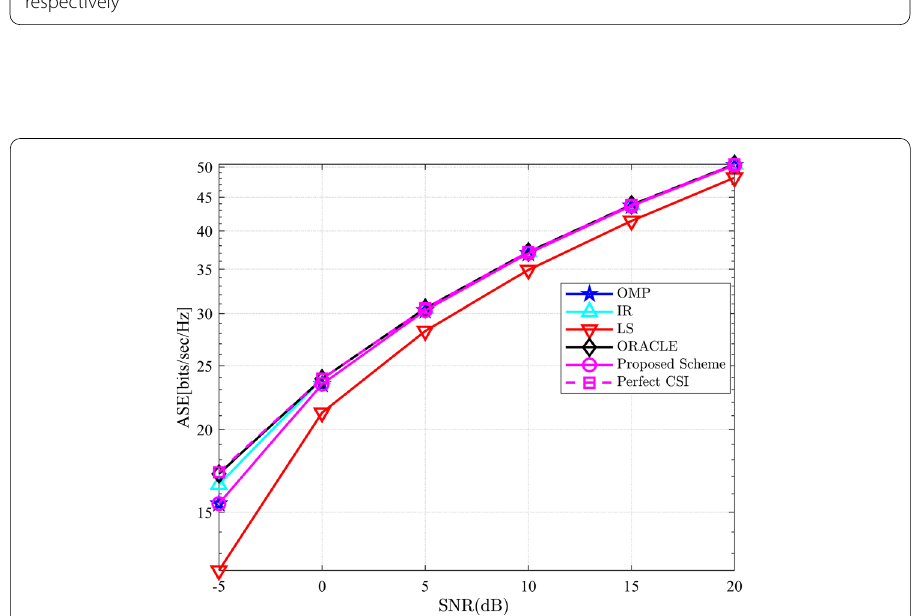
Fig. 10 ASE performance against SNR when N x = N y = 32 , N t = N r = 64 , N RF r = N RF t = 2 are considered,